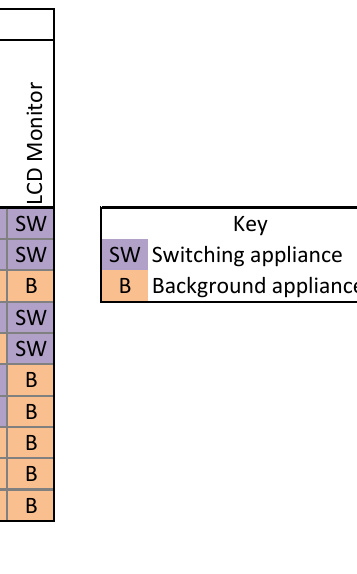
Figure 7. Breakdown of switching and background appliances used in each